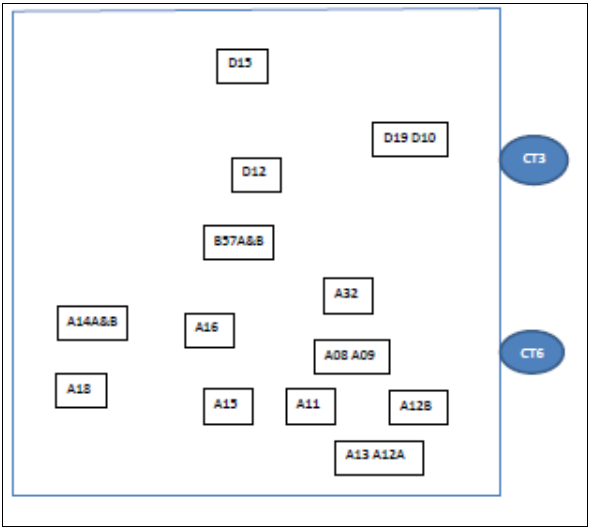
Figure 3. Schematic of Factory 2 showing most of locations of drain/sample points. CT3/CT6 = two cooling towers (with connecting pipework, so treated as one) where samples were also taken.